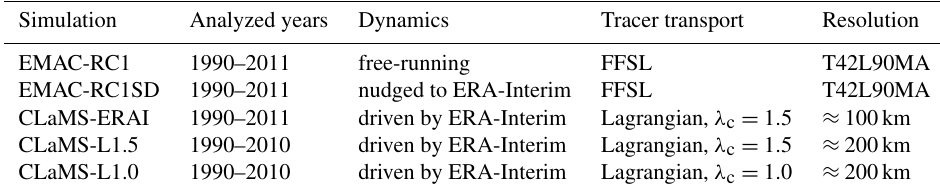
Table 1. Overview of the model simulations with EMAC and CLaMS, used for the present study. The simulations differ with respect to dynamics, tracer transport (advection scheme and for CLaMS also the mixing strength, expressed by a critical Lyapunov exponent λ c in day − 1 ) and